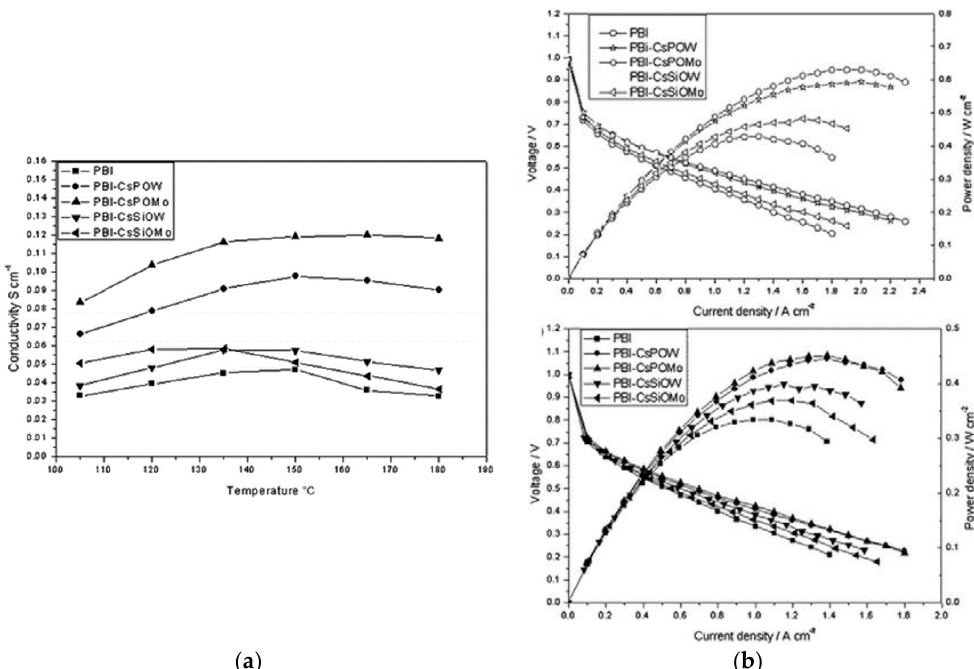
Figure 14. Proton conductivities of PBI composite membrane containing 30 wt.% CsHPA at ADL = 4.5, RH < 1% ( a ); polarization and power density curves of a PEMFC operated at 150 °C with H 2 /O 2 atmospheric pressure (upper plot) and H 2 /air atmospheric pressure (lower plot) ( b ). Reprinted with permission from Ref. [129]. Copyright 2011 Royal Society of Chemistry.